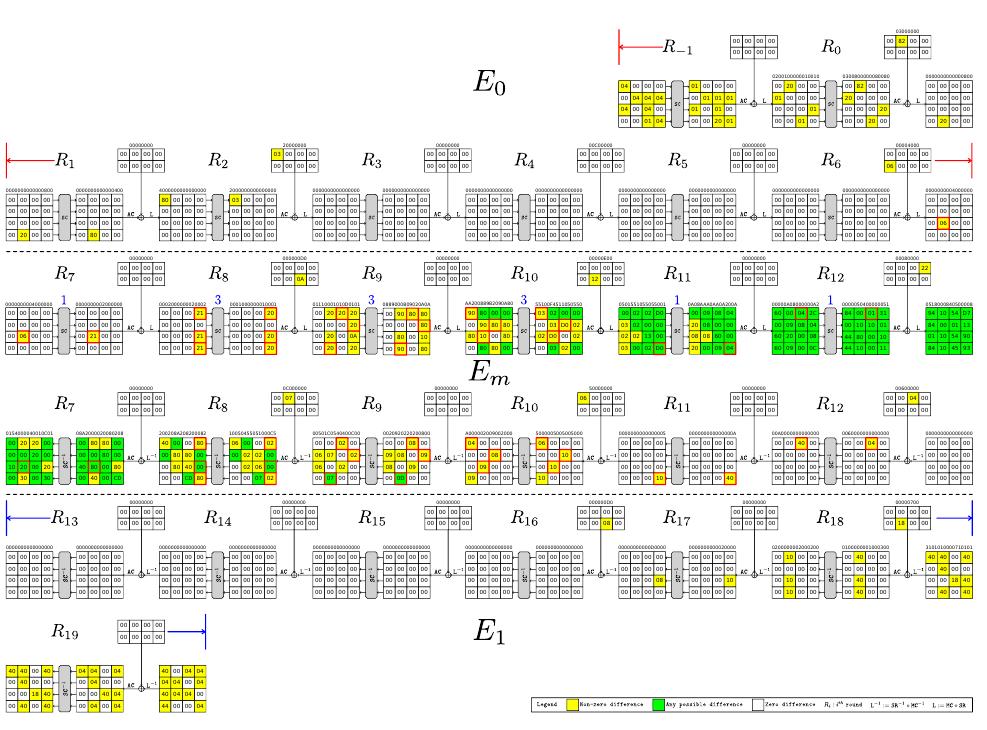
Figure 14: Boomerang distinguisher II for 18 and 19 rounds of SKINNY -64-128, and 18 to 21 rounds of SKINNY